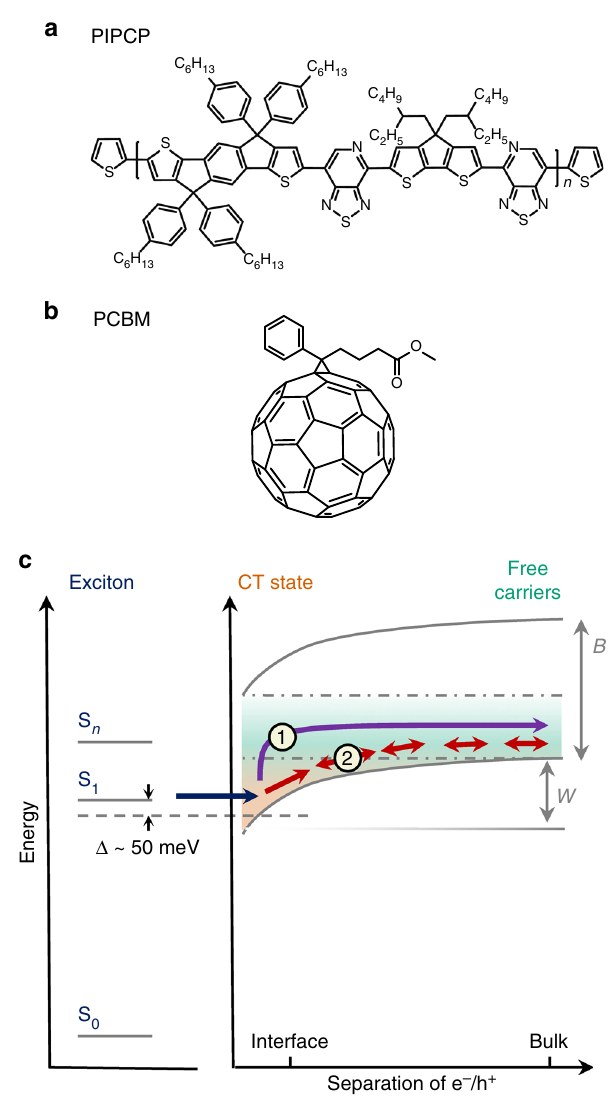
Fig. 1 Charge separation in low-energy loss heterojunctions. Molecular structures for PIPCP a and PCBM b . c Schematic state diagram for electron- hole separation in an organic heterojunction with a small offset energy between the singlet exciton (S 1 ) and the geminate charge transfer (CT) state (dashed line). In contrast to systems with larger-offset energies, direct access to delocalised states, with bandwidth B , is not energetically possible from S 1 . As a consequence, charge separation must overcome the Coulomb potential ( W ) by either thermal population into delocalised states (1) or successive hopping (2) within the density of states. Note that orange represent CT states at the donor – acceptor interface and green represents delocalised, free